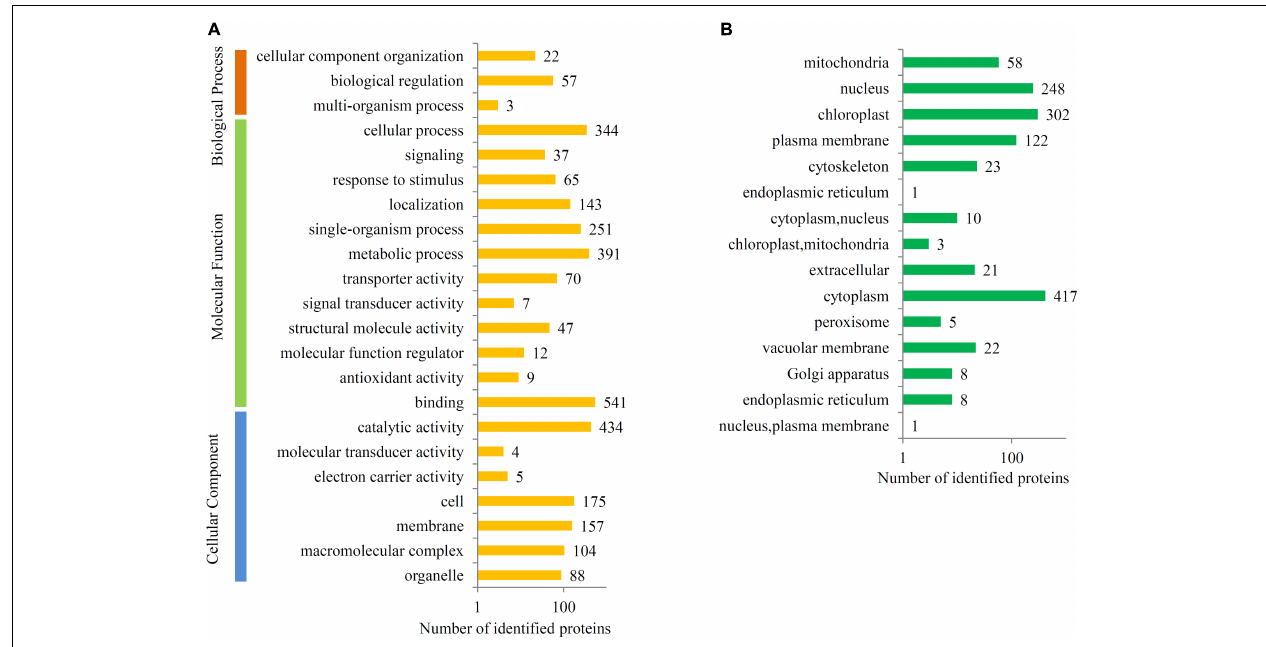
FIGURE 4 | Functional classification of the ubiquitinated proteins. (A) GO analysis of all identified ubiquitinated proteins. All the proteins were groups into three major categories, such as biological process, molecular function, and cellular component. (B) Subcellular location analysis of all identified ubiquitinated proteins. The number of proteins present in each GO class or subcellular location was provided to each bar.